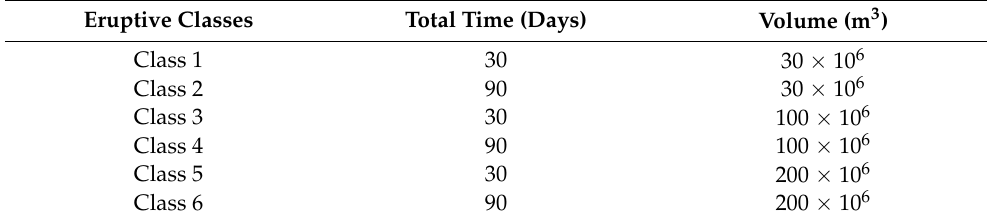
Table 2. Thresholds of the total durations and the lava volumes defined for each eruptive class associated with the flank eruptions (adapted from